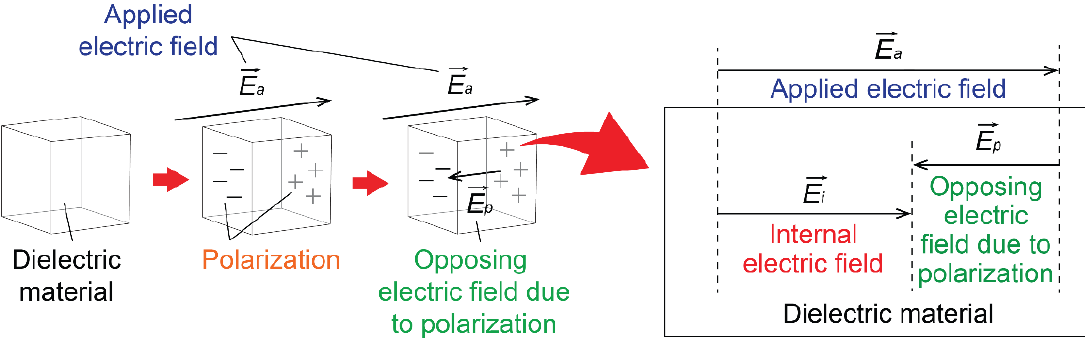
Figure 2. Relationship between the applied (external) and internal electric fields.